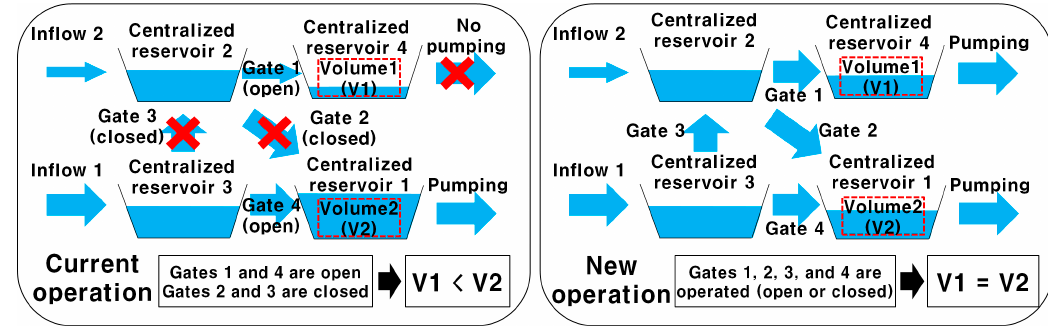
Figure 5. Schematics of the gate operation in centralized reservoirs.